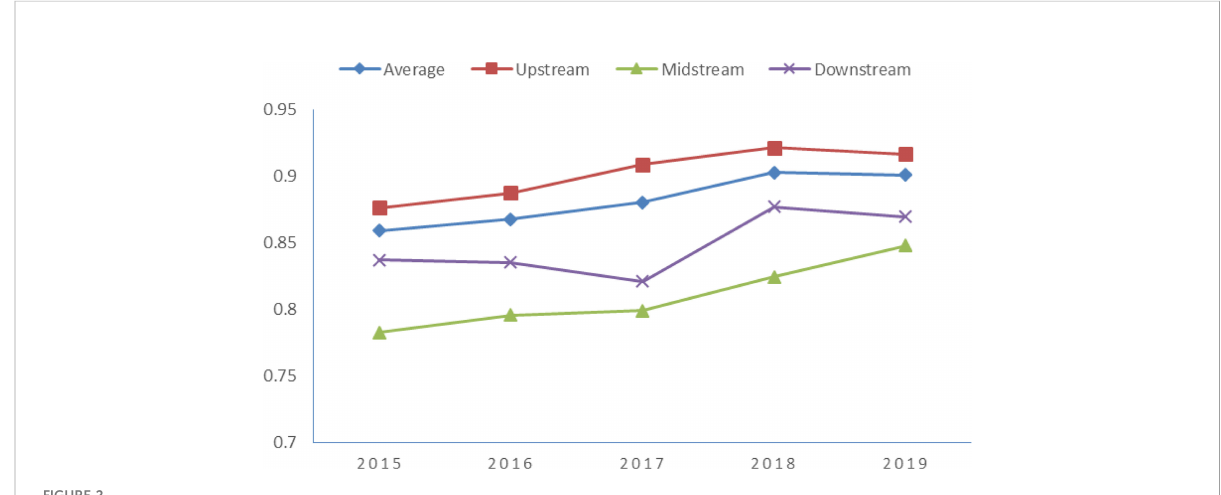
FIGURE 2 GTE values for the average and each link of the industry chain under the meta-frontier,